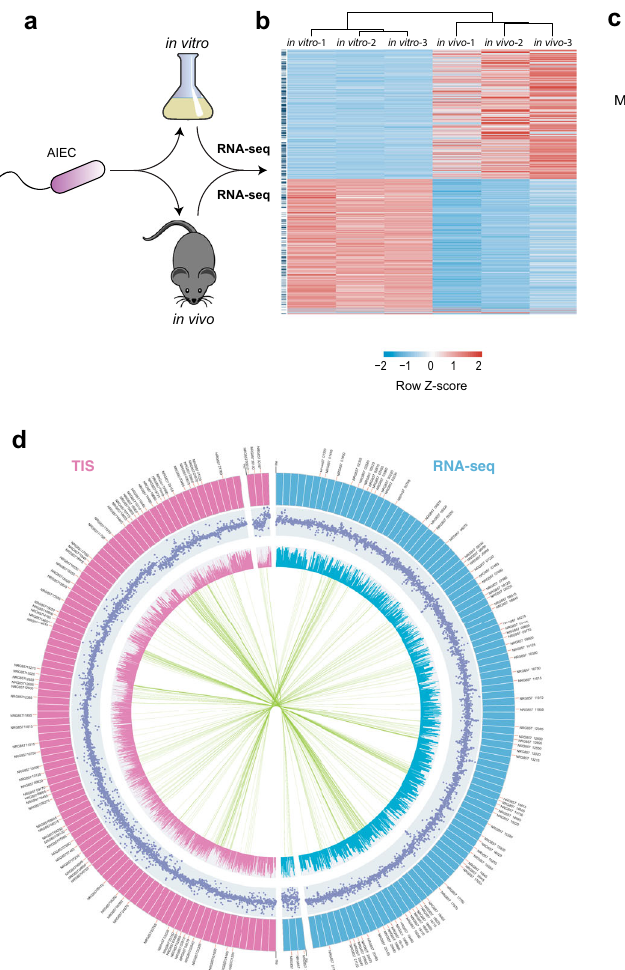
Fig. 2 Combined genome-scale approaches to investigate AIEC infection biology. a Identi fi cation of the AIEC intestinal gene expression pro fi le using comparative transcriptomics. b Heatmap with hierarchical clustering showing the relative gene expression of different AIEC loci in vivo and in vitro. Only statistically signi fi cant transcripts per million (TPM) values are shown (FDR-adjusted P value <0.05). Individual rows marked with a blue line (to left of panel) represent genes involved in metabolic processes. c Bar graph representing the percentage distribution of differentially regulated genes and in vivo - depleted loci relative to the whole genome across different COG families. Hits from TIS and RNA-sequencing shown were obtained from n = 3 biologically independent animals. d Comparisons of the AIEC in vivo fi tness genes and transcriptomic pro fi les. Mean fold change of mutant abundance (pink track) and differential gene expression (blue track) in vivo are displayed on the log scale (dot plot) and the linear scale (histogram). Lines are connecting the AIEC loci that were common between the two